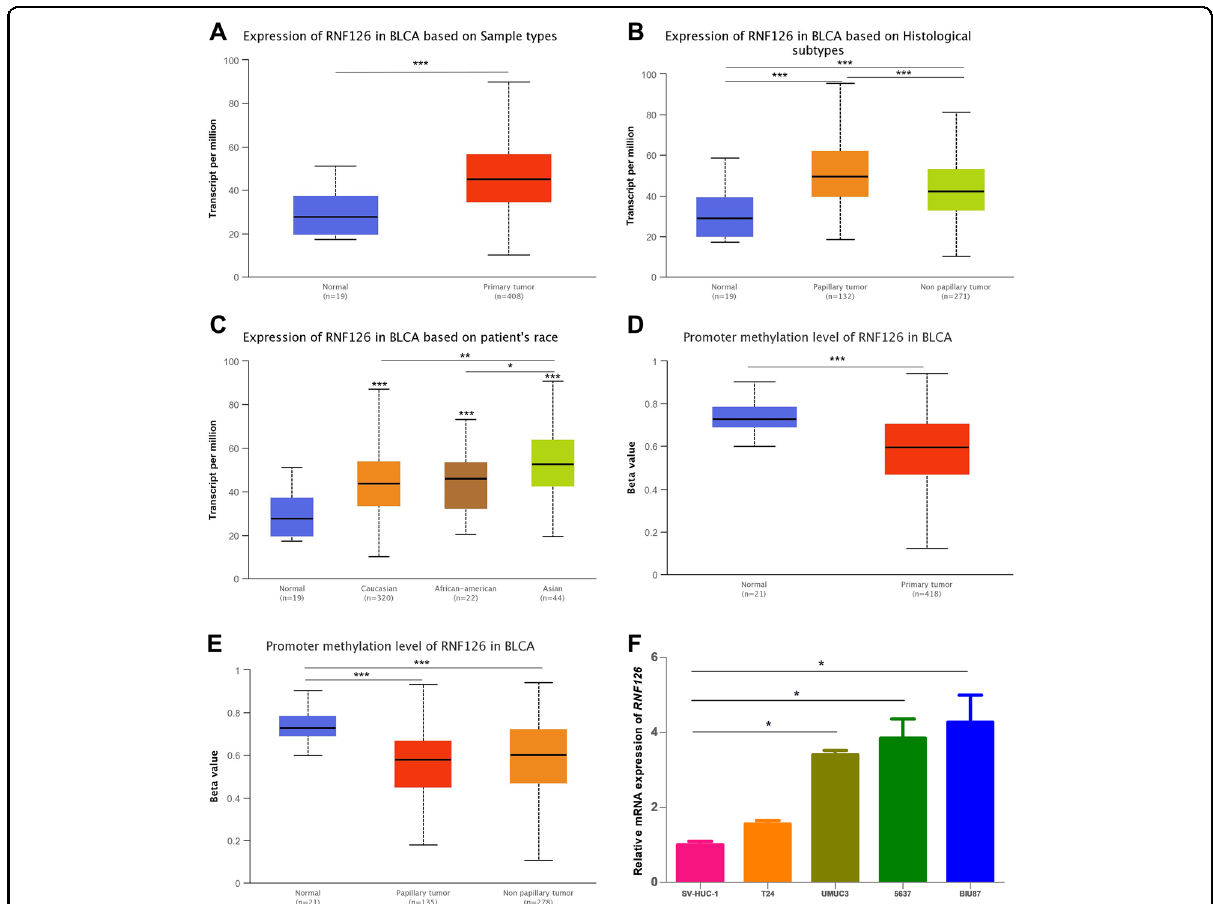
Fig. 1 Expression of RNF126 in BCa of TCGA samples and different cell lines. A RNF126 expression in the normal and primary tumor of the bladder. B RNF126 expression is based on different histological subtypes: papillary tumor and non-papillary tumor. C Expression of RNF126 in BCa based on the patient ’ s race. D Promoter methylation level of RNF126 in BCa. E RNF126 promoter methylation pro fi le is based on histological subtypes. F The qRT-PCR analysis con fi rmed the transcription level of RNF126 in normal bladder epithelial cells SV-HUC-1 and various BCa cell lines (T24, UMUC3, 5637, BIU78). *** p < 0.001, ** p < 0.01, * p <